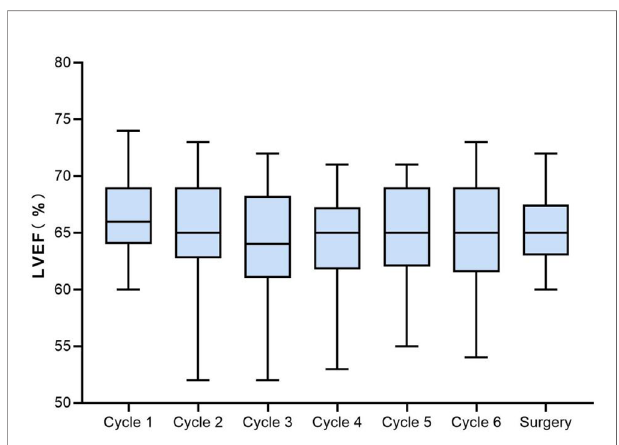
FIGURE 3 | Boxplots of LVEF from baseline to surgery in the assessable population. LVEF, left ventricular ejection